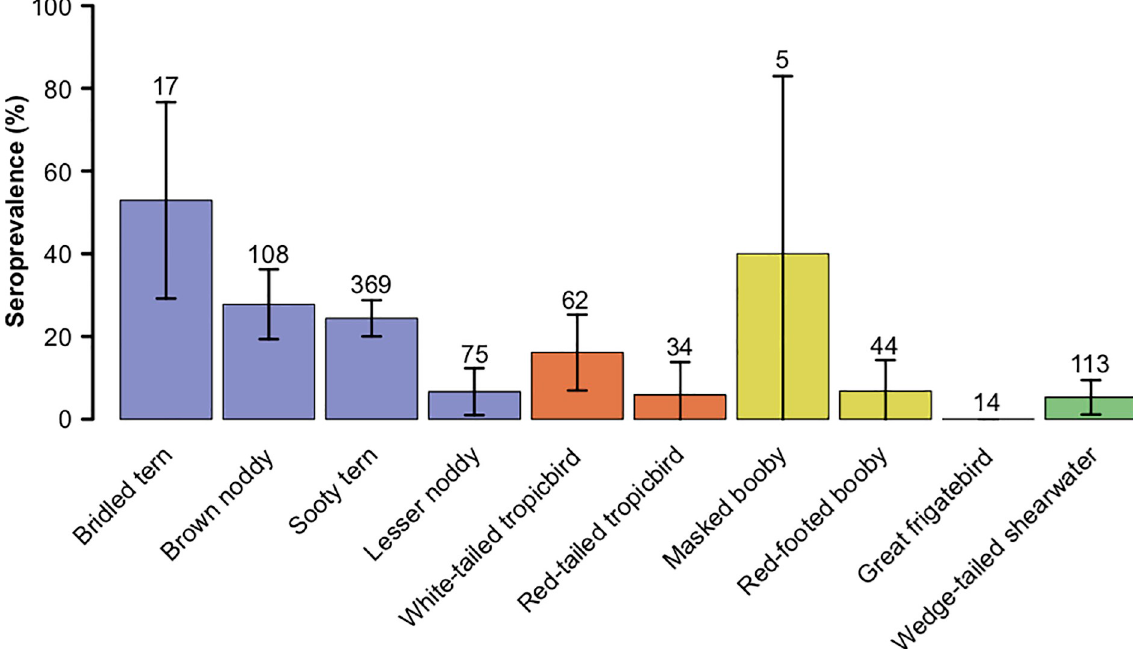
Fig 2. Seroprevalence of antibodies to Toxoplasma gondii per species in the adult seabirds sampled in the Western Indian Ocean (sample size and percentage with 95% confidence intervals). Colours indicate bird orders (blue: Charadriiformes, red: Phaethontiformes, yellow: Suliformes, green: